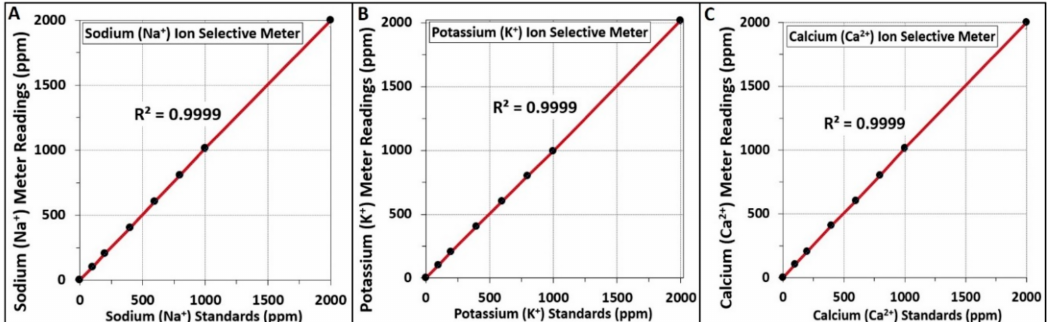
Figure 3. Ion analyses on standardized salt solutions using ion selective electrode (ISE) meters used in this study. Panel ( A ), ion analysis of Na + using NaCl standards; ( B ), ion analysis of K + using KCl standards; ( C ), ion analysis of Ca 2 + using CaCl 2 standards. Individual standards were prepared in triplicate and data points represent the mean of triplicate samplings with error bars representing the standard deviation of the mean. The coe ffi cient of determination is a measure of the linearity of the data points to the trendline is indicated by R 2 value.